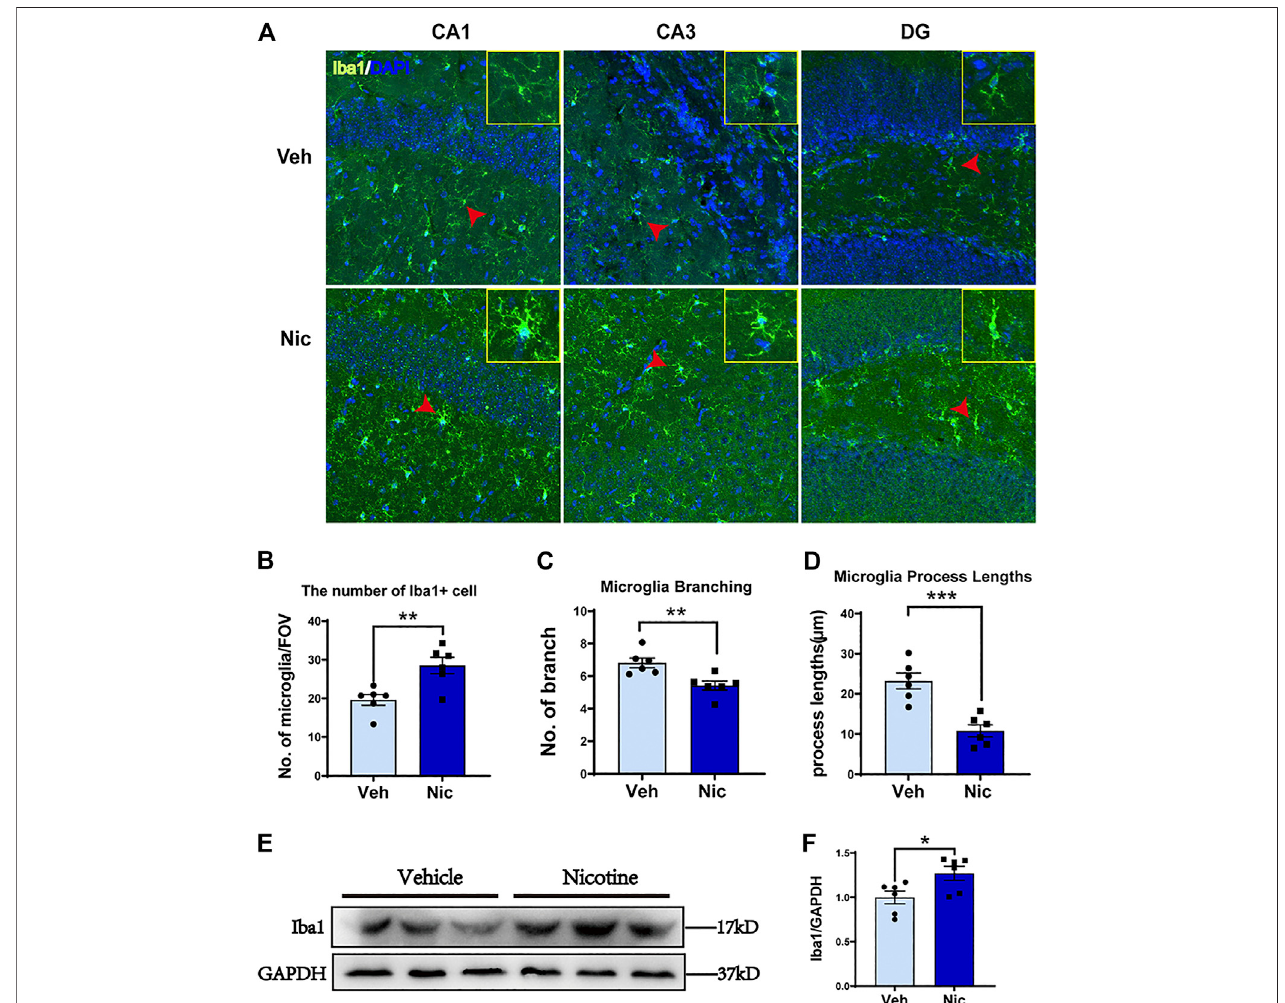
FIGURE 5 | Nicotine exposure increased the number of Iba1 positive microglial cells and promoted M2-like microglial polarization in the nicotine- exposed offspring ’ s hippocampus. The morphology of microglia was detected by immuno fl uorescence staining. Representative images of the Iba1 expression in CA1, CA3, and DG were shown (A) . Olympus FV3000 Confocal Microscopy was used to get a Z-stack for 3-D reconstruction, and images showed that microglia cells changed their morphology from branching (in the control) to amoebic (in the nicotine-exposed group) in the offspring hippocampus. Nicotine exposure increased hippocampus microglial number (B) , but decreased microglial branching (C) and microglial process lengths (D) . CA1, CA3, and DG areas were used to generate the date presented in B-D. A point represented a calculated average of each measurement. (E, F) Iba1 protein level was increased in nicotine offspring revealed by western blot, as compared to vehicle offspring. * p < 0.05; ** p < 0.01; *** p < 0.001; **** p < 0.0001. Scale bar (cid:1) 50 μ m all data are means ±